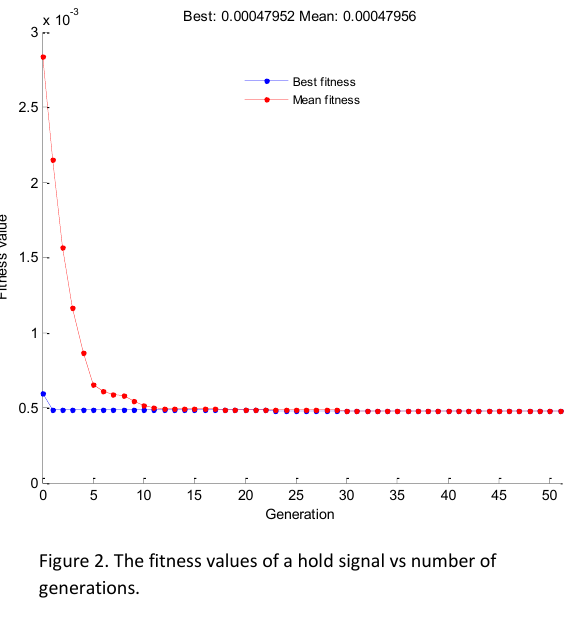
Figure 2. The fitness values of a hold signal vs number of generations.